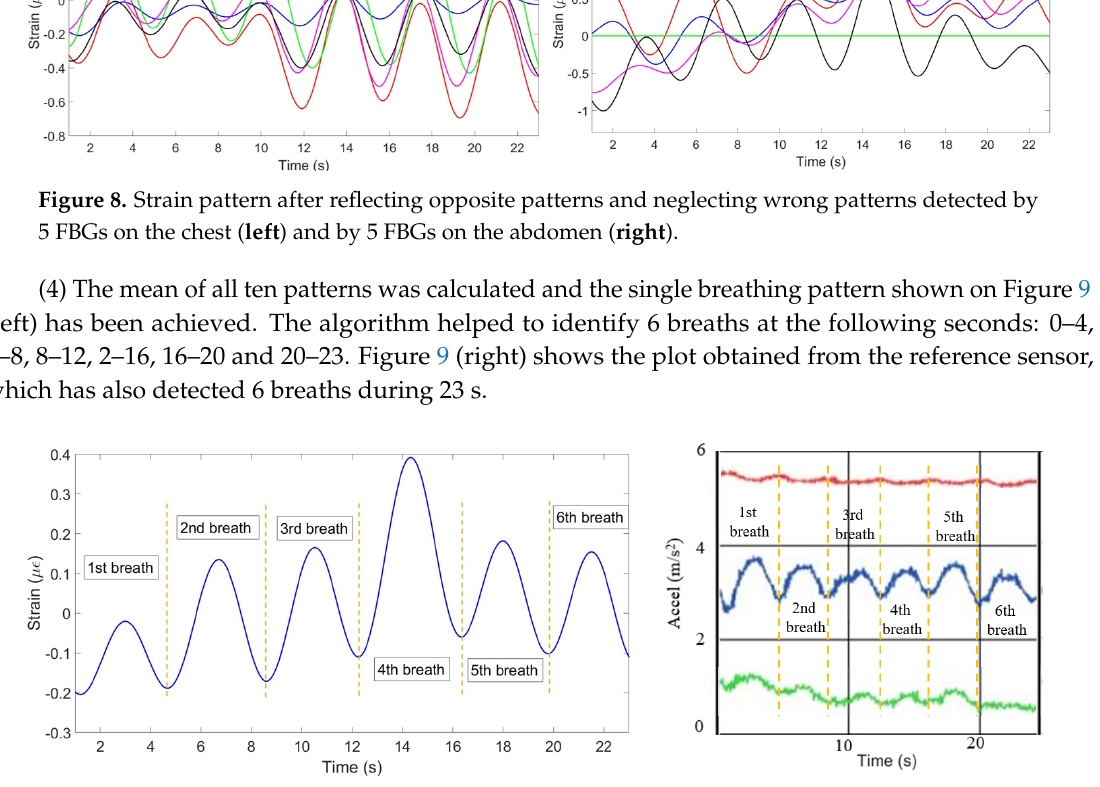
Figure 9. Breathing pattern reconstructed based on the 10 FBGs strain patterns ( left ) and obtained from the reference sensor ( right